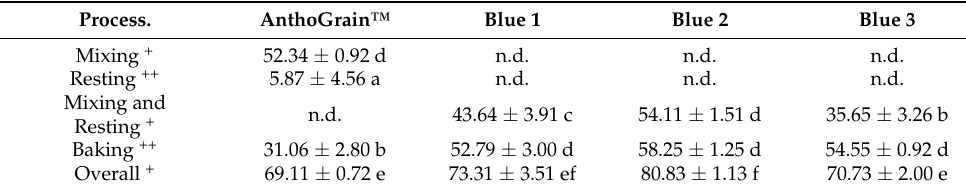
Table 2. Loss of total anthocyanin content (expressed as %) at each cracker processing step. Process.